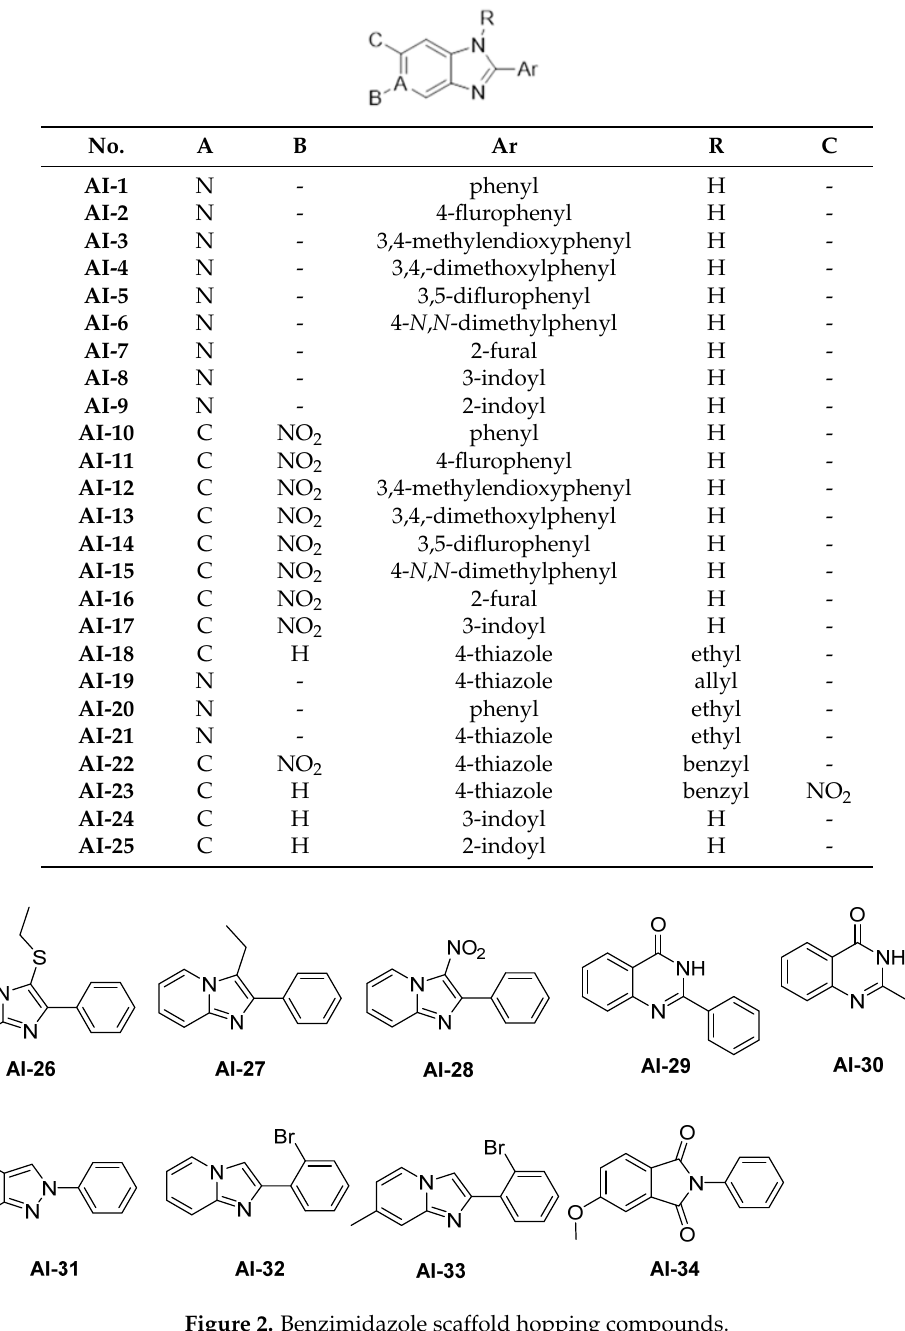
Table 2. Structures of compounds AI ‐ 1 – 25 .